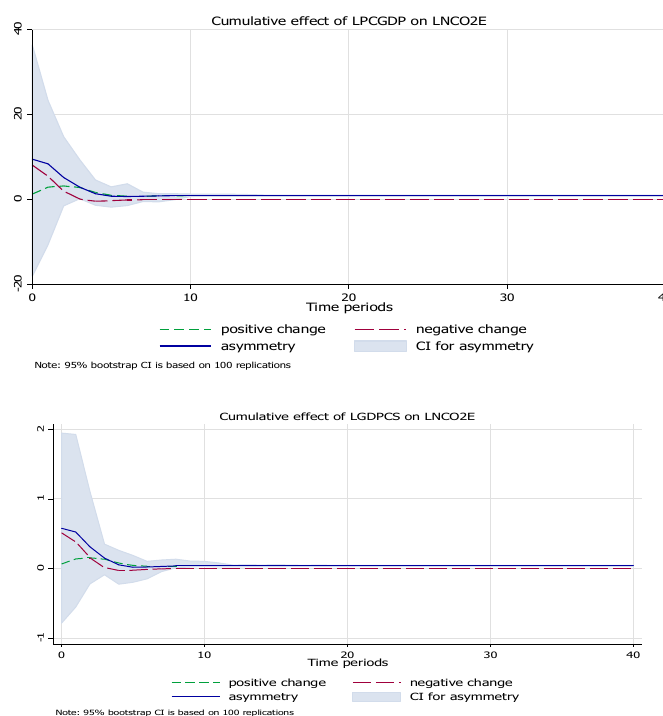
Figure 4. Stability test of coefficient in NARDL.